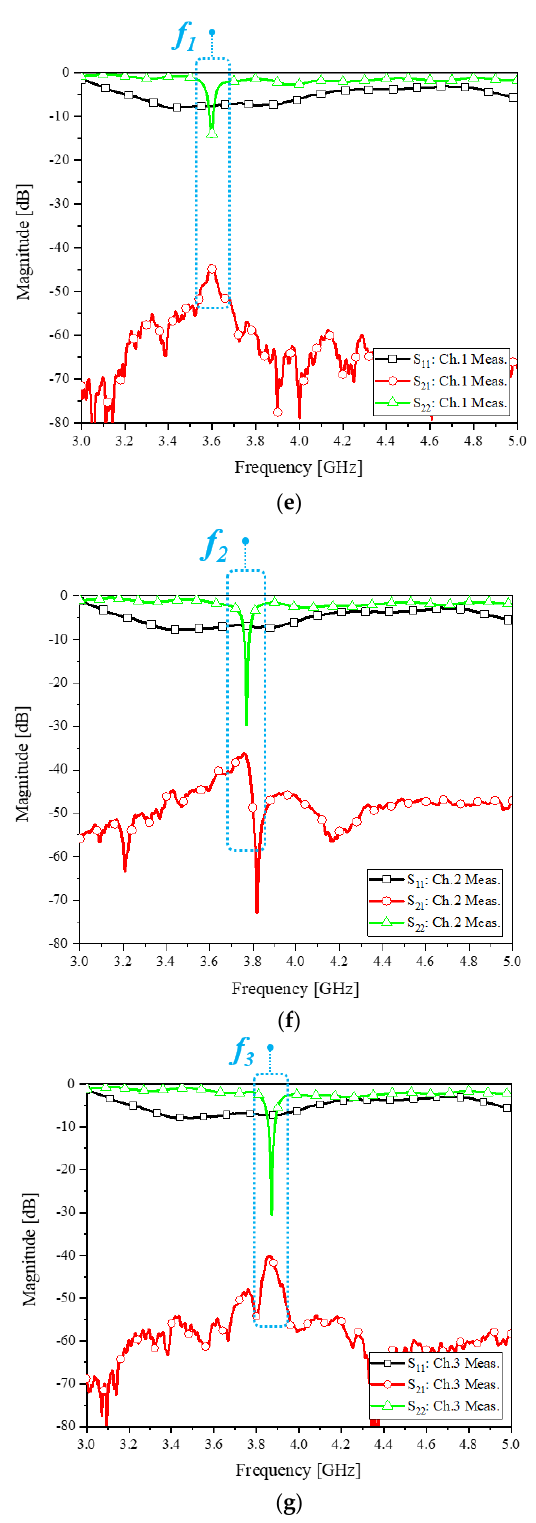
Figure 6. Test results of channel selection ( a ) Measured passbands of the filters ( b ) Simulated and measured far-field patterns of the RX antenna at f 1 , f 2 , and f 3 ( c ) Antenna gains of the RX antenna with columns as TX signals and rows as RX channels ( d ) Photograph of the realistic the TX to RX antenna wireless link test-setup ( e ) Antennas’ S ii and received f 1 signal ( f ) Antennas’ S ii and received f 2 signal ( g ) Antennas’ S ii and received f 3 signal. Table 2. Comparing the differences of the proposed work and others’.